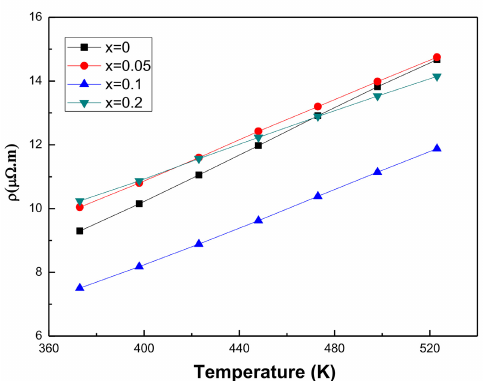
Figure 12: Electrical resistivity of In-doped Bi 2 Te 3 bulk samples versus temperature. Reproduced from Ref.